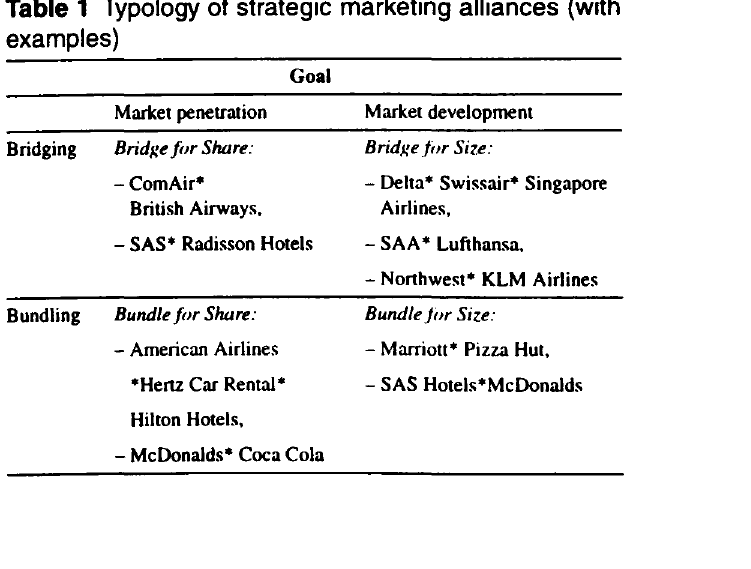
Table 1 Typology of strategic marketing alliances (with